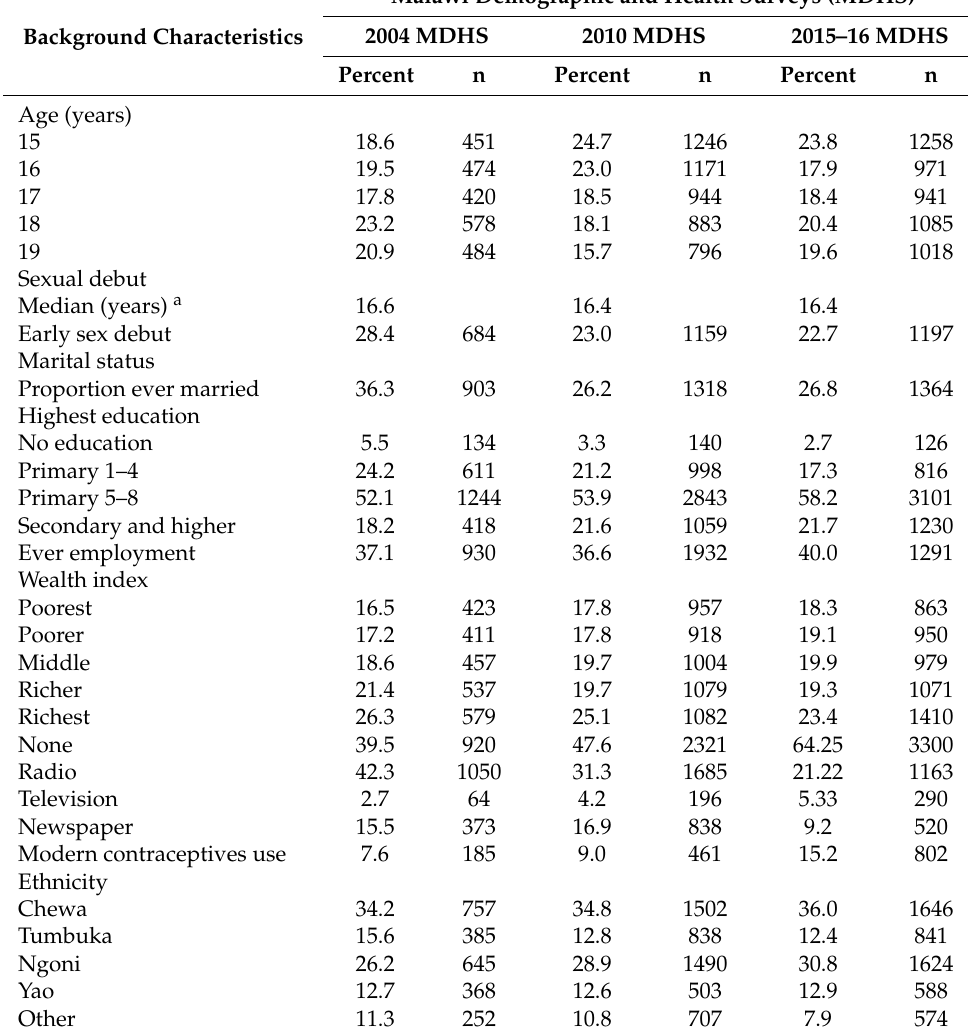
Table 2. Summary statistics for the study